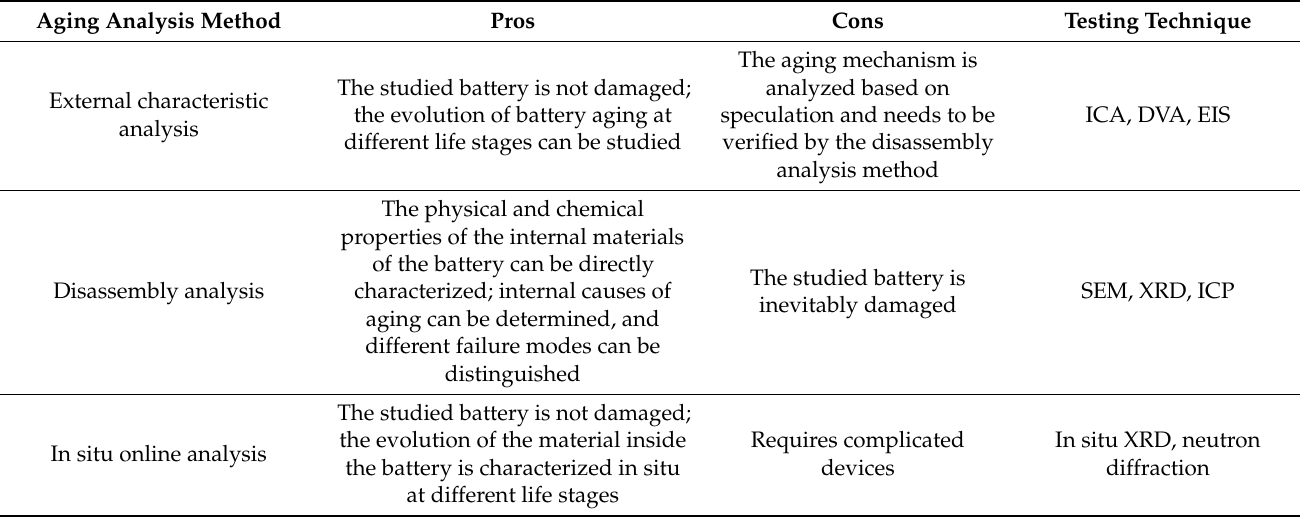
Table 2. Comparison of three methods for analyzing aging mechanisms of